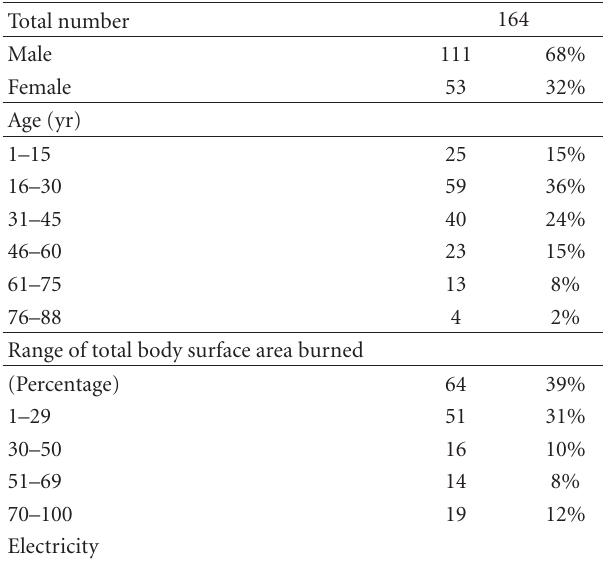
Table 1: Characterization of 164